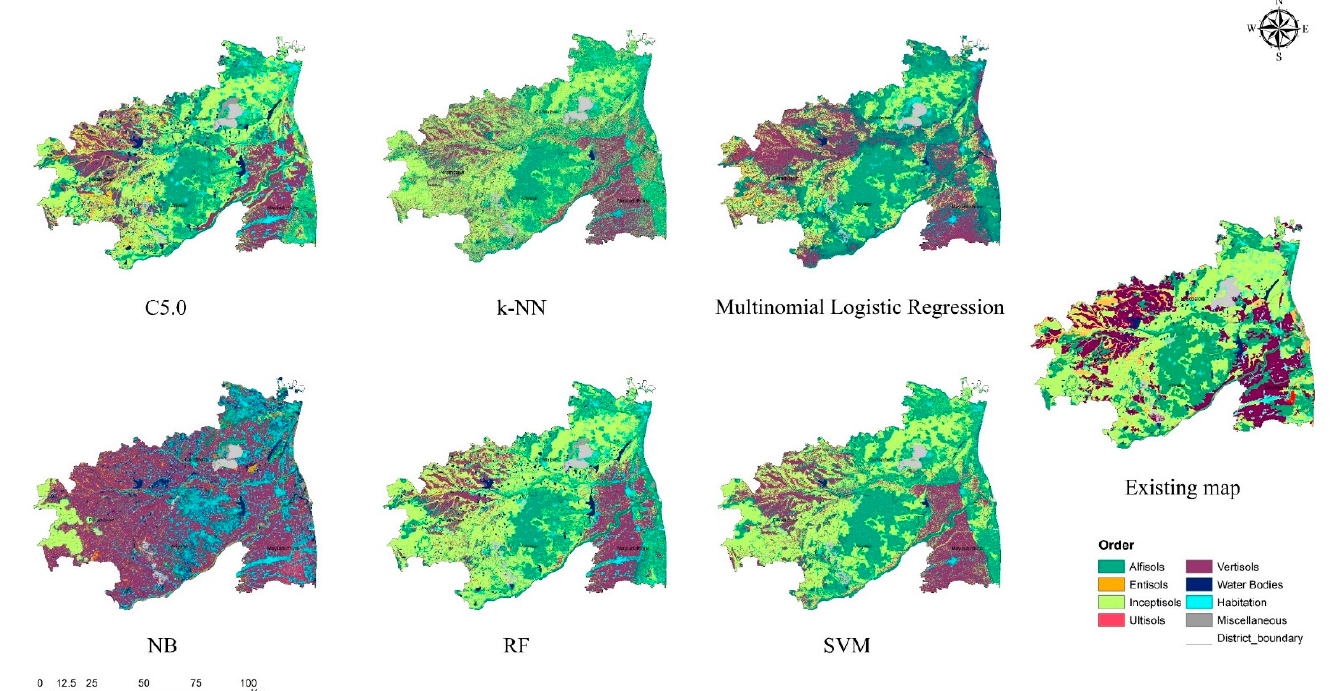
Figure 5. Existing and predicted maps of soil order using different machine learning algorithms.